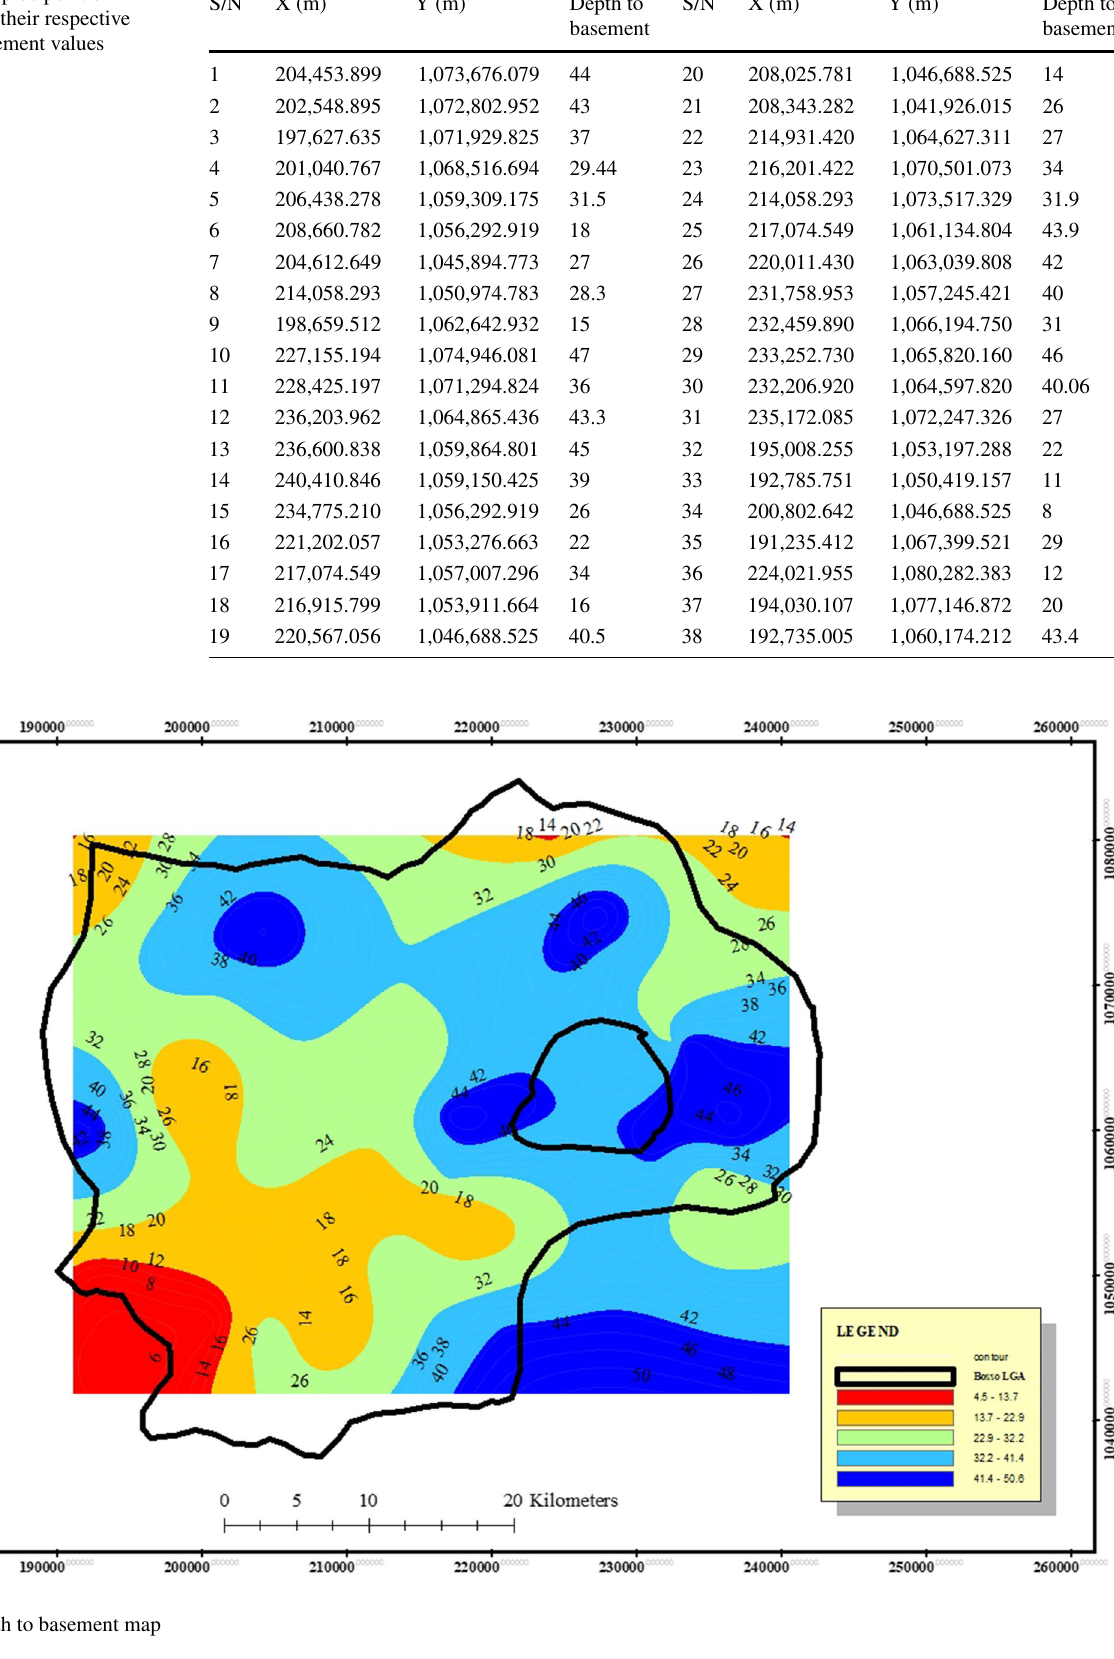
Table 9 Sampled point’s location and their respective depth to basement values